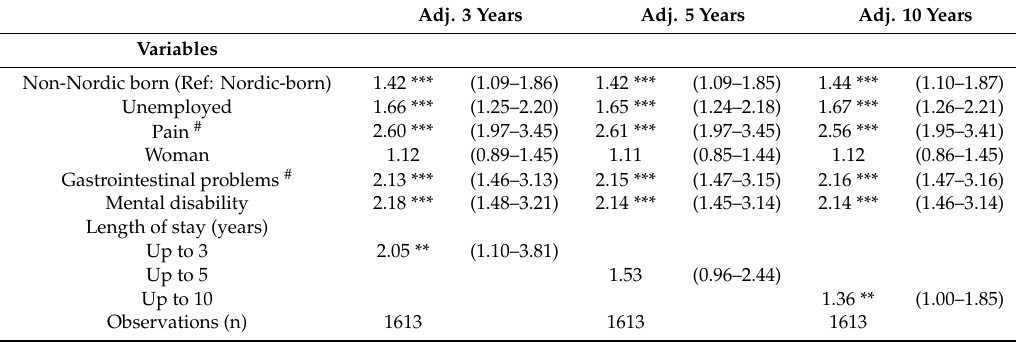
Table 4. Adjusted (Adj.) odds ratios (OR) with 95% confidence intervals (95% CI) as having CSSP, when adjusted for categories of lengths of stay in